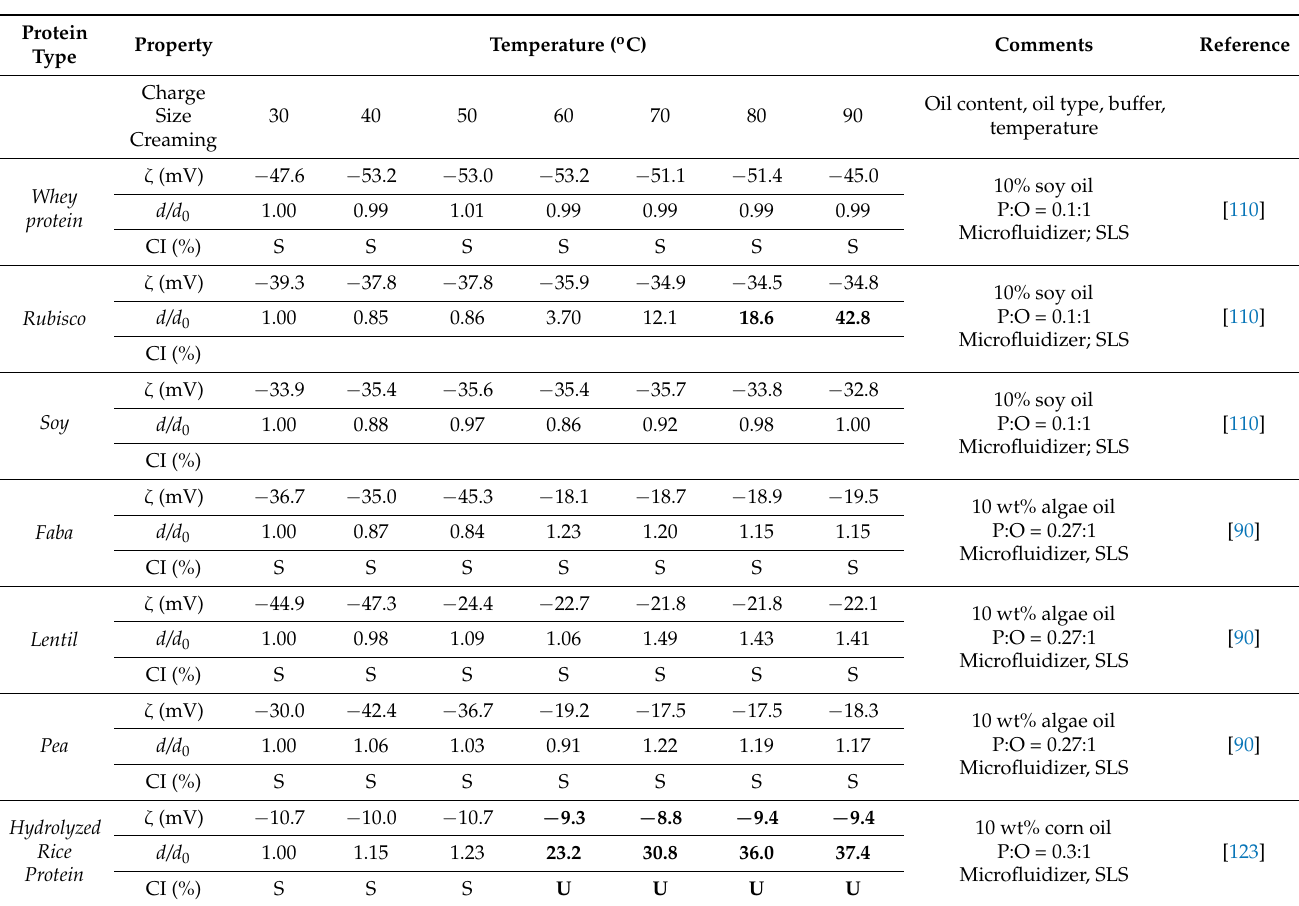
Table 4. Temperature stability of protein-coated oil droplets in oil-in-water emulsions. Regions in bold show where extensive droplet aggregation occurs. Key: ζ = ζ -potential; d/d 0 is the particle diameter at specified temperature divided by particle diameter at ambient temperature; CI is the creaming index measured after storage for certain time at ambient